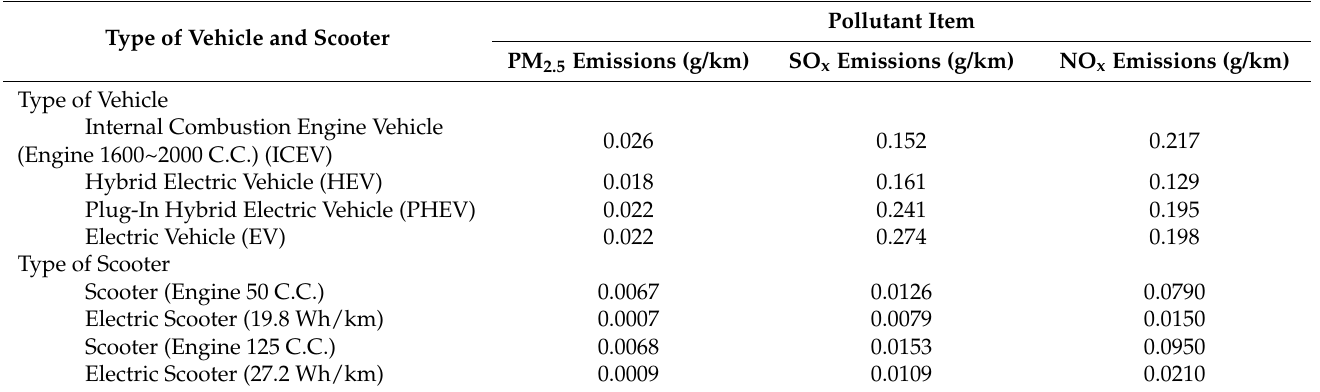
Table 3. PM 2.5 , SO x , and NO x emissions via LCA for different types of vehicles and